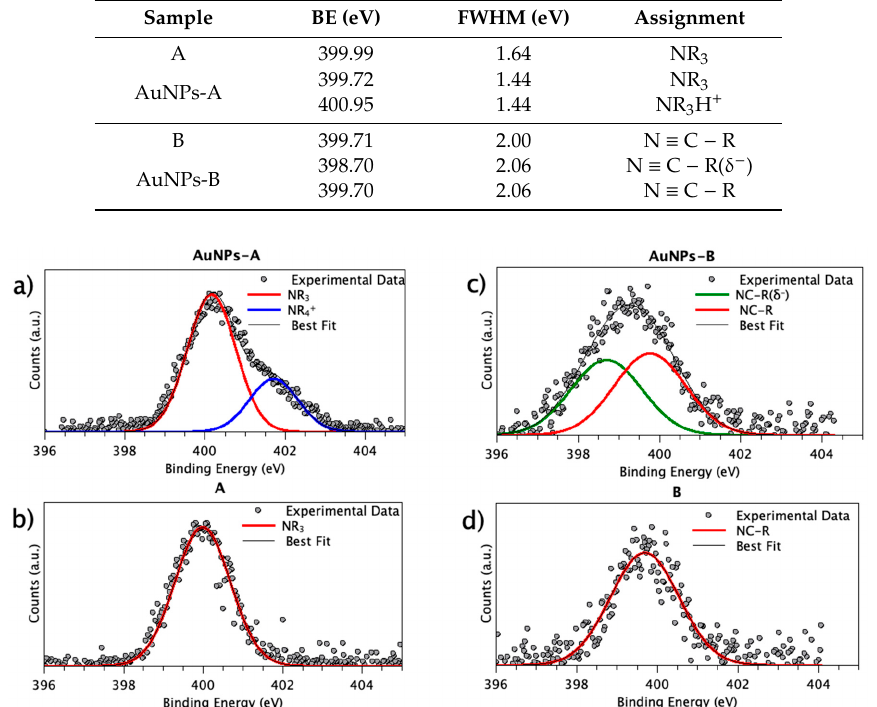
Figure 4. High-resolution x-ray photoelectron spectroscopy (HR-XPS) N1s spectra of: ( a ) AuNPs-A; ( b ) complex A; ( c ) AuNPs-B; ( d ) complex B. Table 1. N1s BE, FWHM values and assignments for pristine Cu(I) complexes and AuNPs carriers.